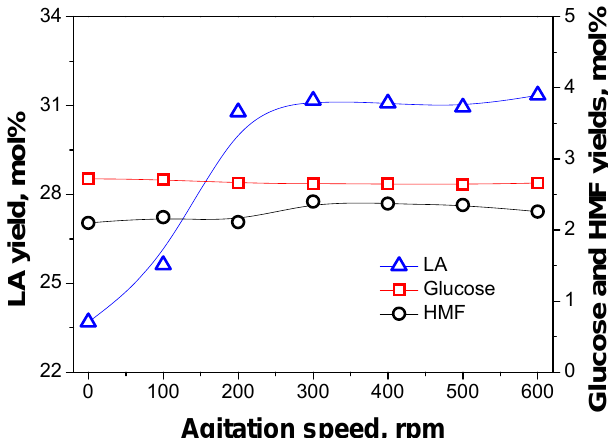
Figure 6. Effect of agitation speed on yields of